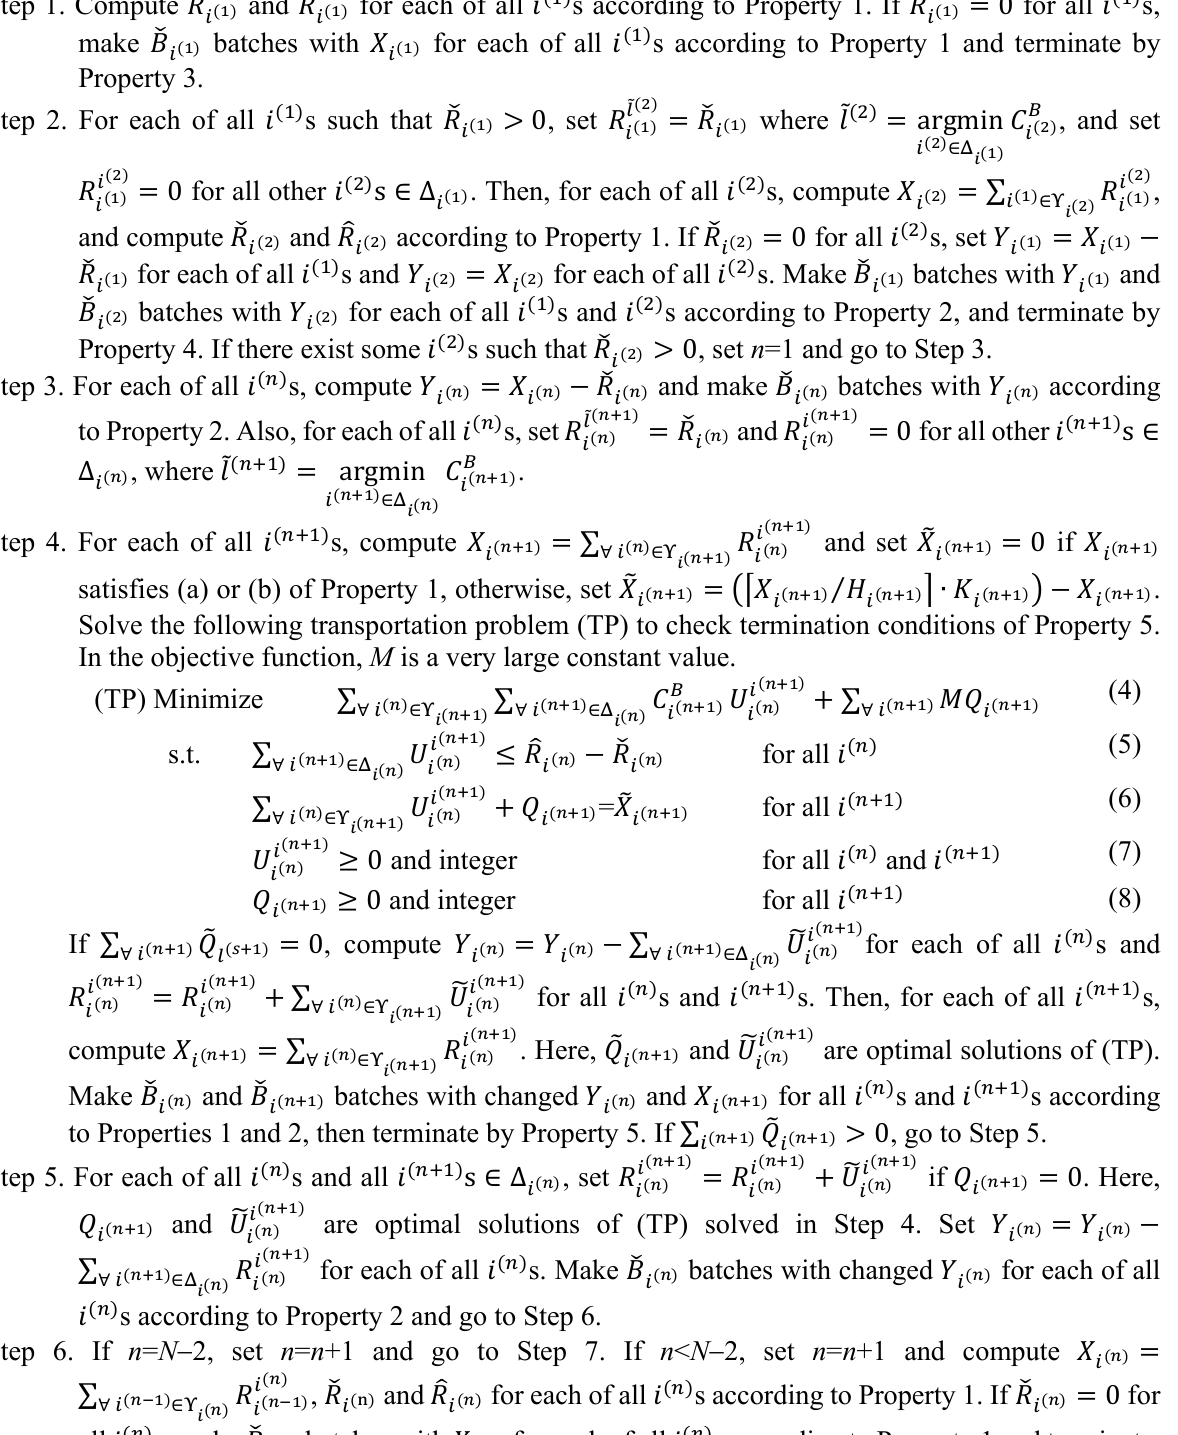
Procedure 1 ( Sequential Batching Algorithm